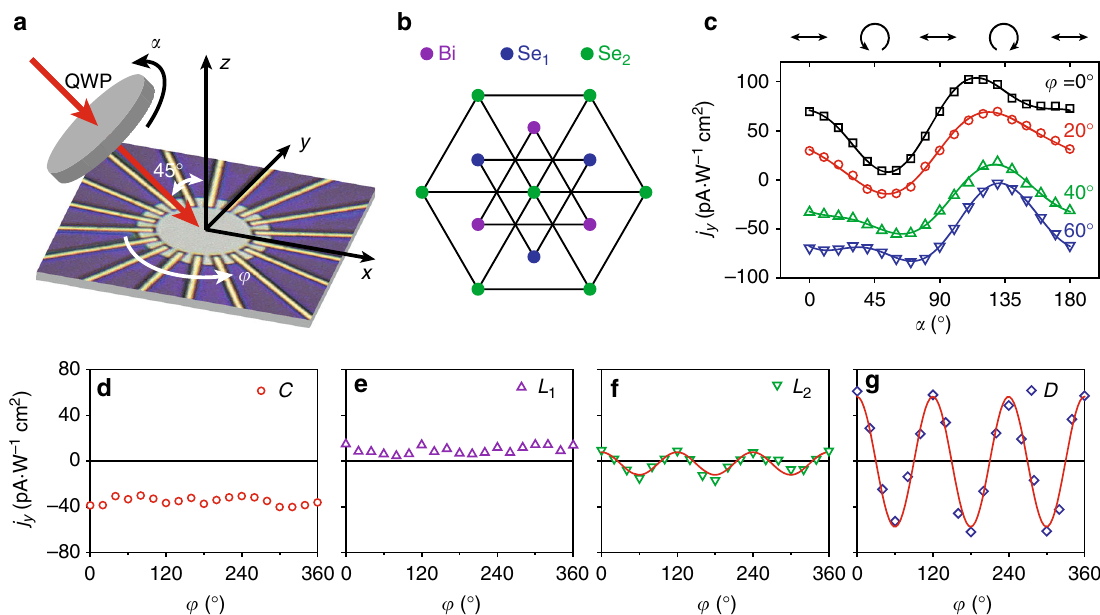
Fig. 2 Anisotropy of the photogalvanic effects in Bi 2 Se 3 . a Measurement scheme. The polarization of the incident light is changed by rotating a quarter waveplate with angle α . The Bi 2 Se 3 is patterned to a circular disk. Nine pairs of electrodes are used to measure photocurrent generate along different directions when the sample is rotated with angle φ . b The lattice structure of the Bi 2 Se 3 crystal showing threefold rotational symmetry along the z -axis. c Polarization-dependent photocurrent collected with electrode pair positioned along the y -axis when the sample is rotated to representative values of φ . d – g Parameters ( C , L 1 , L 2 , D ) extracted from the measurement in ( c ) as a function of φ . While L 2 and D show clear anisotropy with threefold rotational symmetry in agreement with the crystal structure of Bi 2 Se 3 , C and L 1 show no obvious angular dependence. The fi tting errors for all the coef fi cients are very small and hence not shown